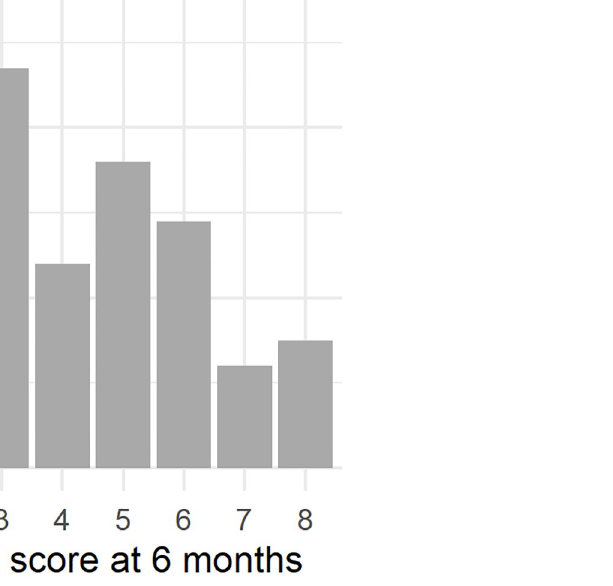
PLOS ONE | https://doi.org/10.1371/journal.pone.0243427 December14,